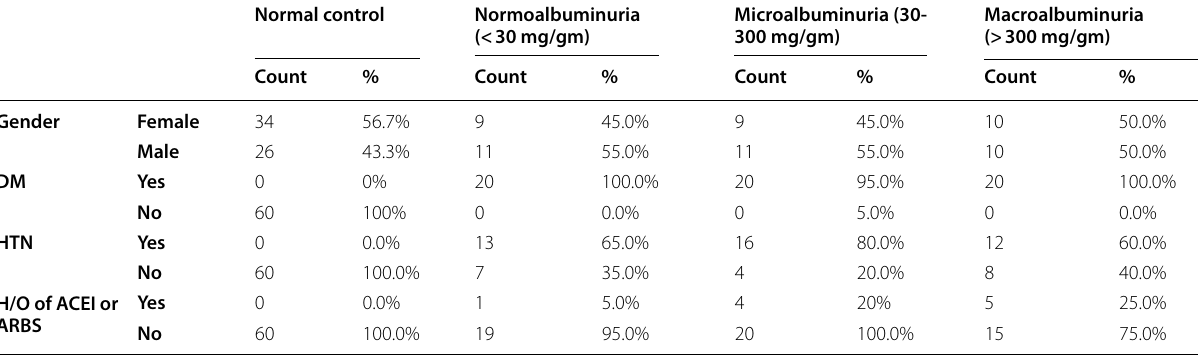
Table 1 Baseline characteristics of the study population Normal